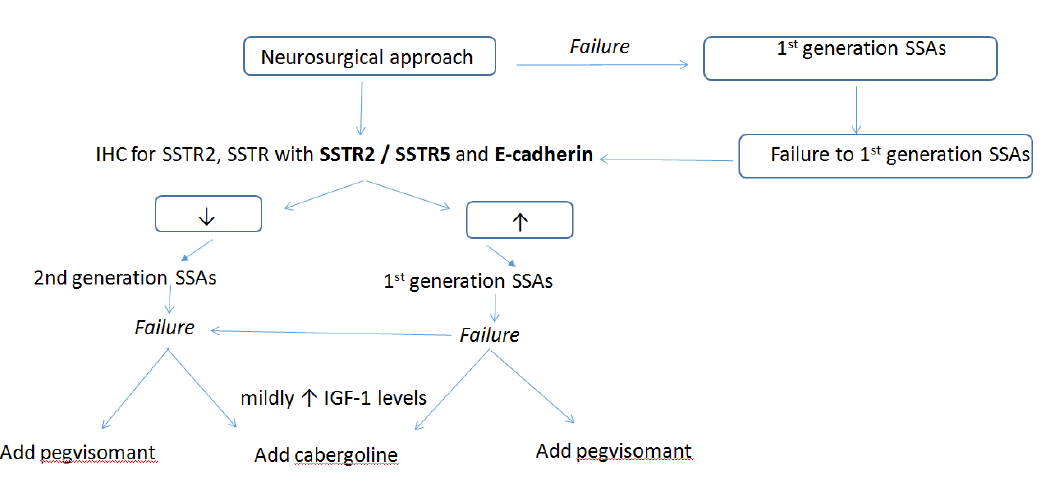
Figure 4. Suggested algorithm of the use of biomarkers in clinical practice. insulin-like growth factor-1 (IGF-1); IHC: immunohistochemistry; SSAs: somatostatin analogues; SSTR: somatostatin receptor.